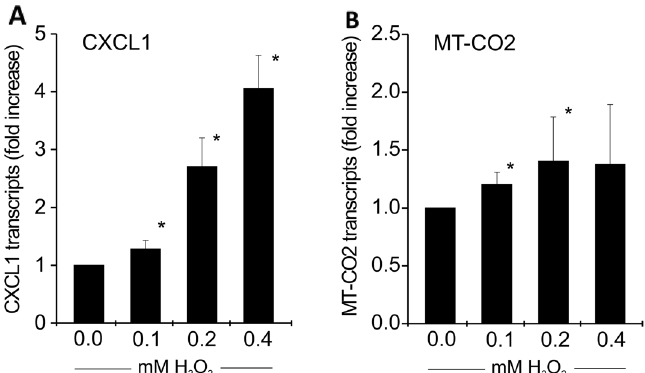
Figure 6. Induction of MT-CO2 and CXCL1 by oxygen peroxide. The effect of H2O2 on both CXCL1 and MT-CO2 transcripts was studied in the 16HBE cell line (human bronchial epithelial cells). Cells were treated with H2O2 for 4 hs, RNA was isolated and RT-PCR was performed (for method details see supplement). Results are normalized to alpha enolase and expressed as fold increase over untreated cells, n = 3 independent